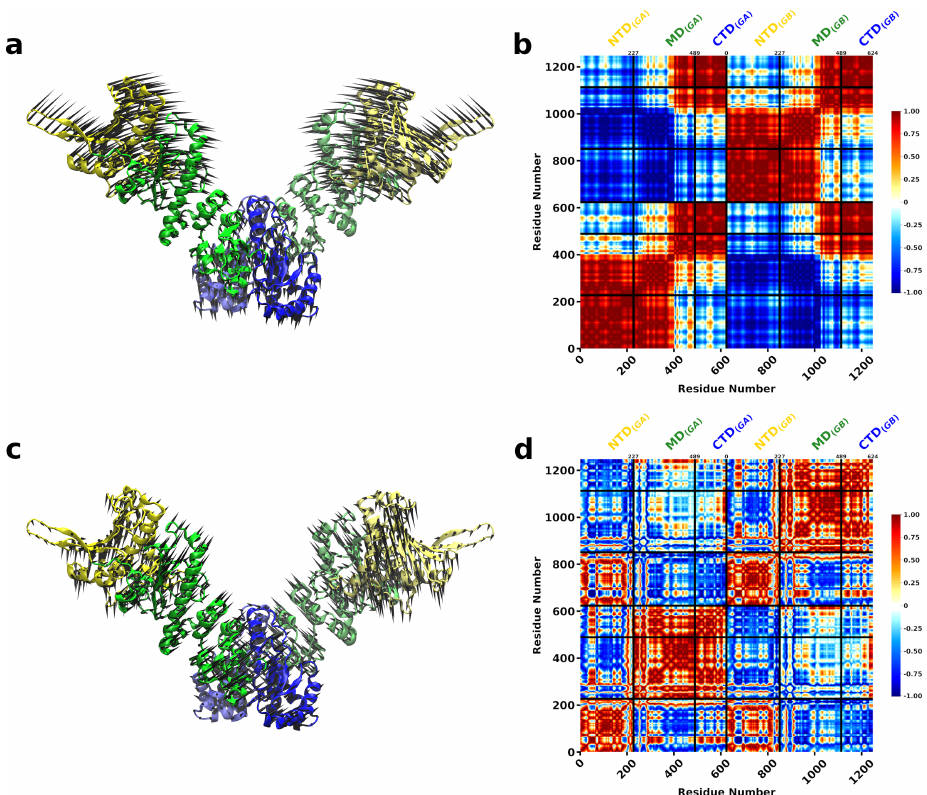
Figure 3. Motions associated with significant normal modes of Hsp90 Ec alone. ( a ) Mode 7 consists of swing motions of each protomer that contributes to closing and dimerization. ( b ) Covariance matrix of amino acid pairs for Mode 7 ( c ) Mode 8 consists of torsional motions about the CTD. ( d ) Covariance matrix of amino acid pairs for modes 8. Arrows in ( a , c ) indicate the amplitude and direction of motions of amino acids in each mode. The color scheme highlights the Hsp90 Ec N-domain in yellow, M-domain in green, C-domain in blue. Correlated movements in covariance matricies ( b , d ) are highlighted in red while anticorrelated movements are represented in